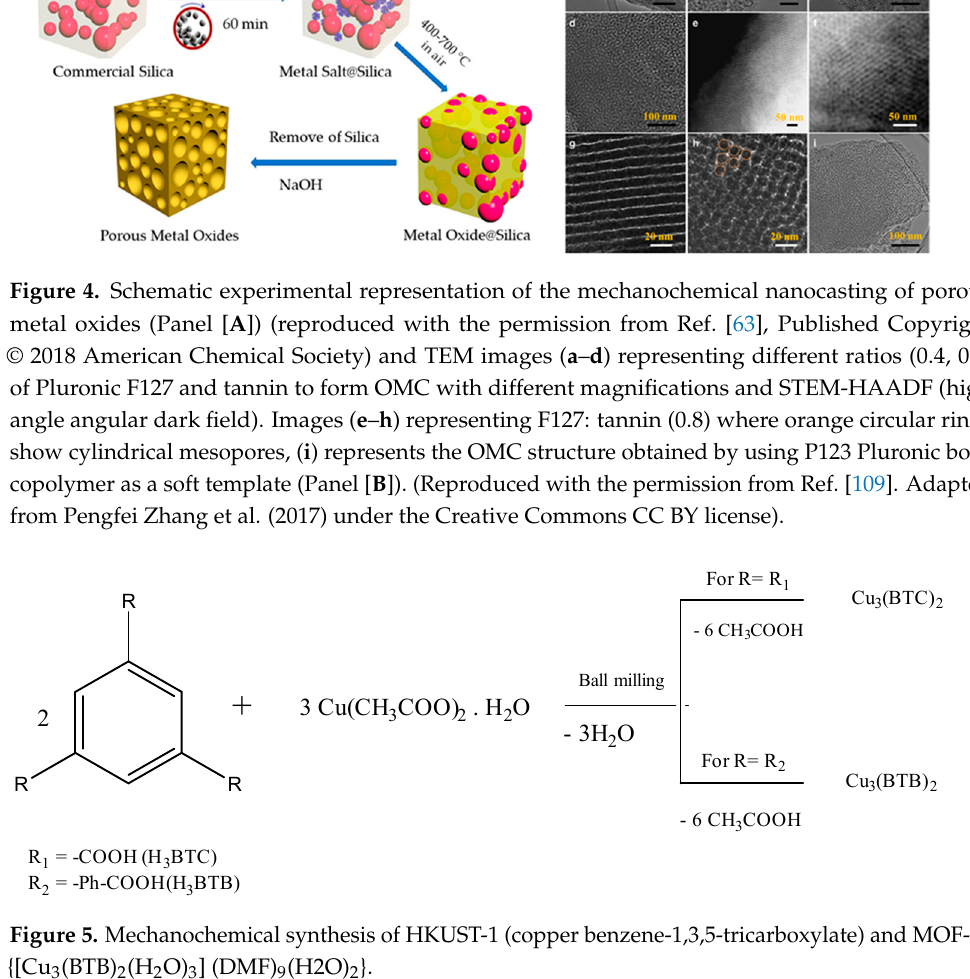
Figure 5. Mechanochemical synthesis of HKUST-1 (copper benzene-1,3,5-tricarboxylate) and MOF- 14 {[Cu 3 (BTB) 2 (H 2 O) 3 ] (DMF) 9 (H2O) 2 }.